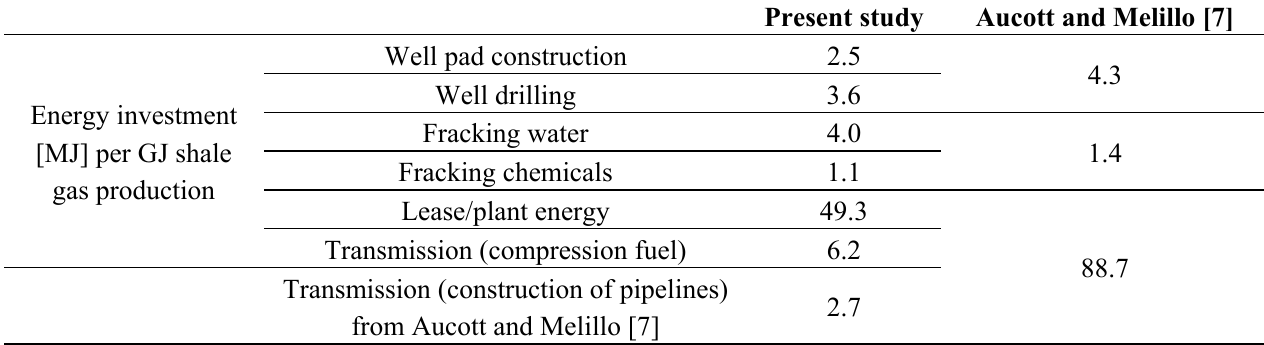
Table 8. Comparison of energy investment [MJ] per GJ unit shale gas